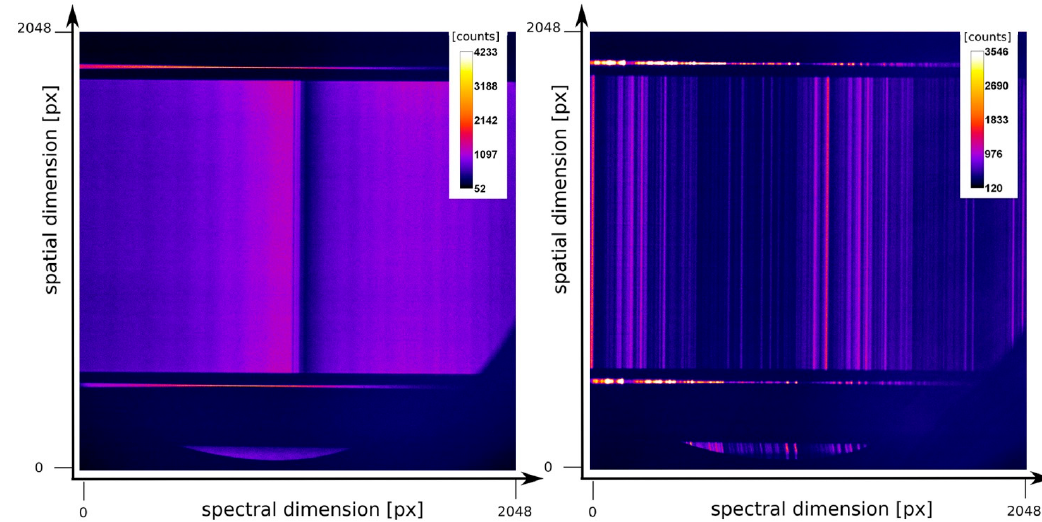
Figure 6. Detector image of a tungsten spectrum ( Left ) taken with the so-called S2 structure (design energy 450 eV) of the RZP A9. In the reference structure on the top and bottom, the oxygen K-edge absorption from the mylar foil is visible. ( Right) : Detector image of an iron spectrum taken with the so-called S3 structure (design energy 780 eV). Design energy of the reference structure: 966.45 eV. The integration time was 945 ms at a laser repetition rate of 100 Hz. Detector: Back-illuminated soft X-ray CCD camera (Greateyes GmbH).